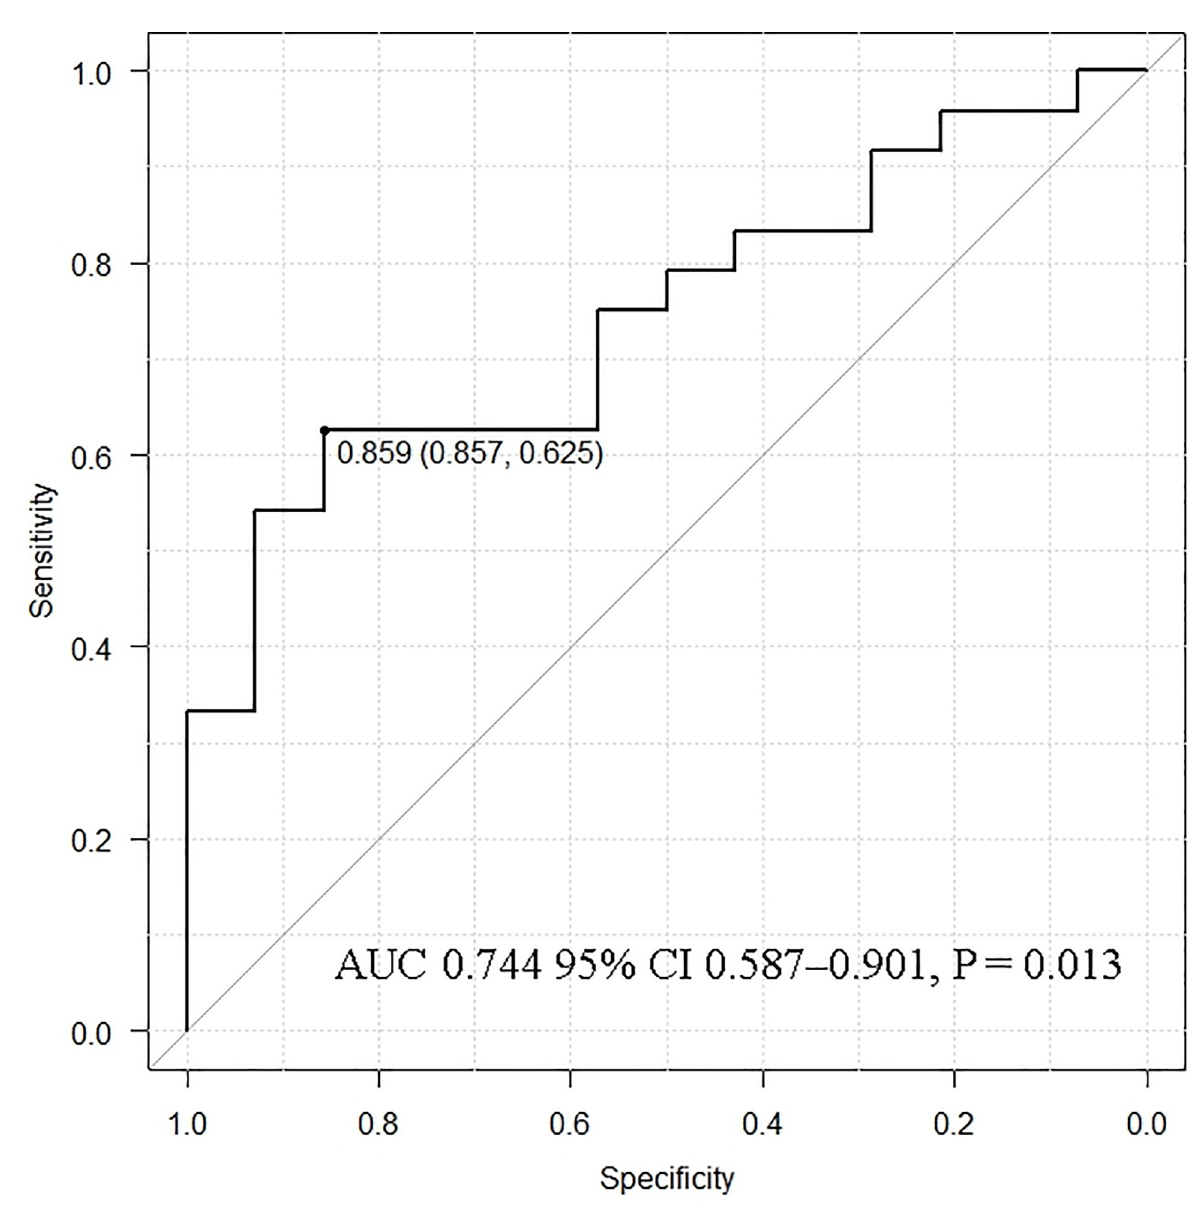
Fig 6. Receiver operating characteristic curve analysis for the cutoff value of recurrence or persistence in the neck or mediastinum. AUC, area under the curve; CI, confidence interval.